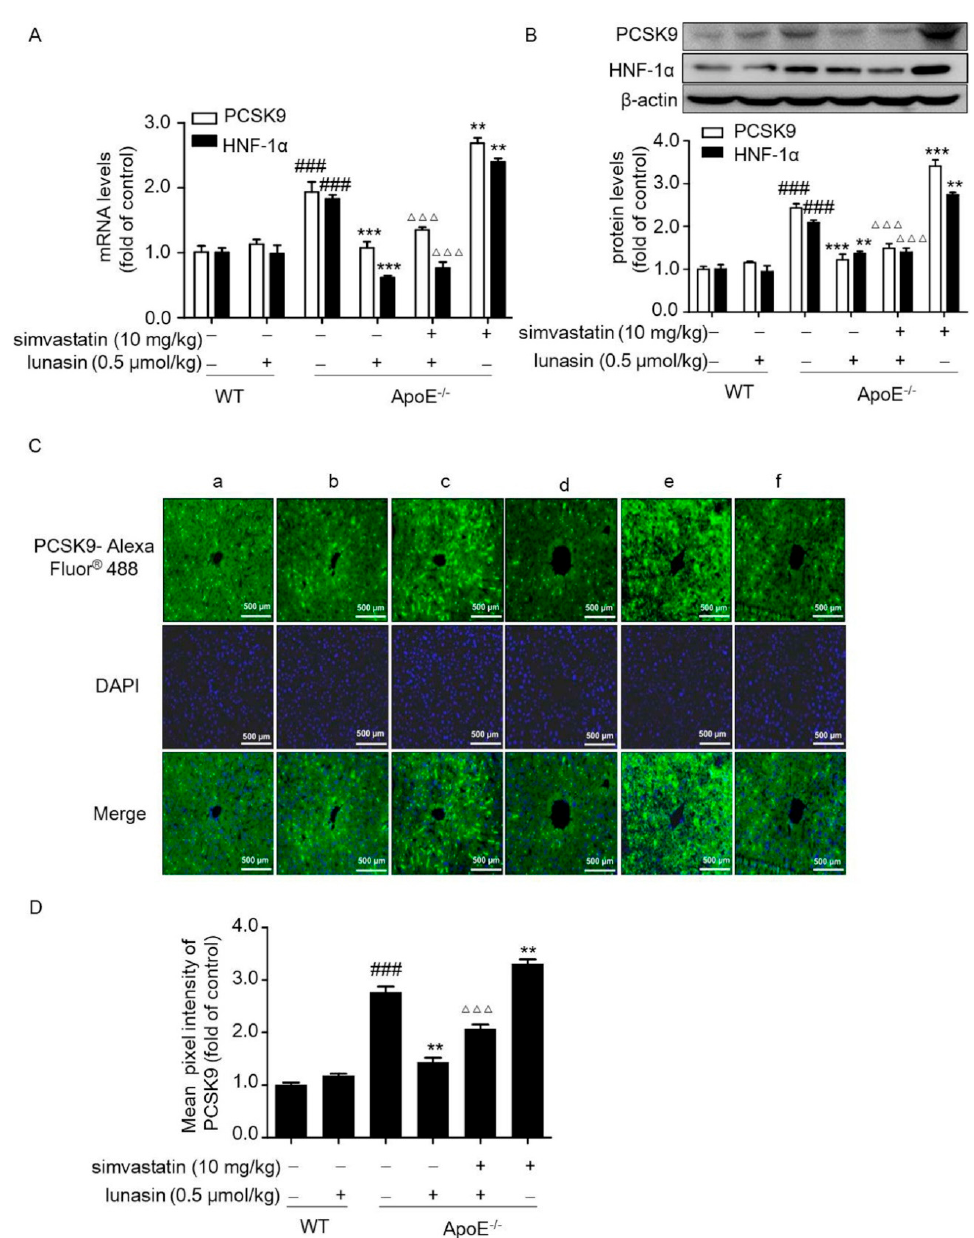
Figure 3. The combination of simvastatin with lunasin suppresses the up-regulation of PCSK9 induced by simvastatin in ApoE − / − mice. ApoE − / − mice were administrated with 10 mg / kg simvastatin and /